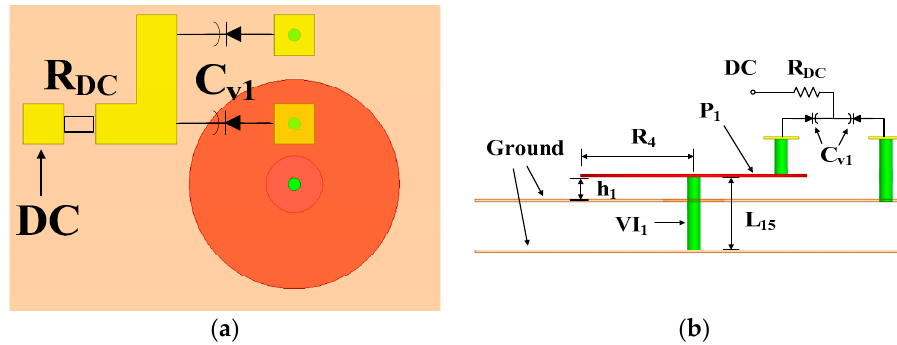
Figure 2. Schematics of the proposed tunable resonator: ( a ) top view; ( b ) side view.